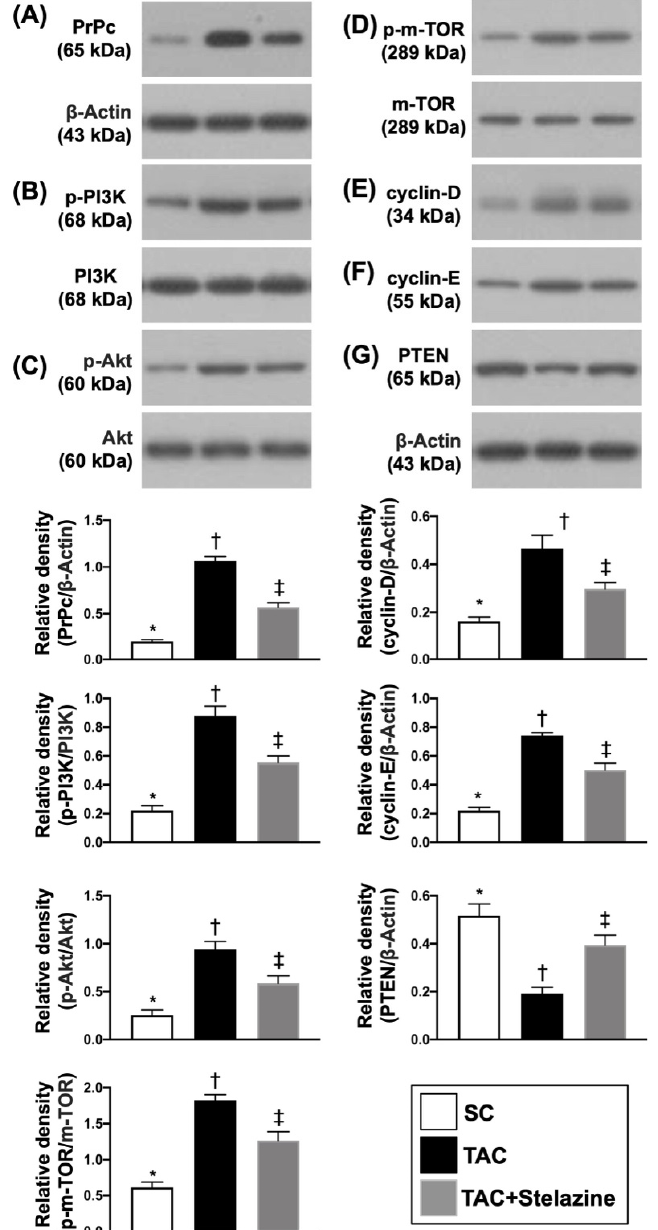
Figure 5. Protein expressions of PrP C , cell stress, and proliferation signalings by day 28 after TAC procedure. ( A ) Protein expression of PrP C , * vs. other groups with different symbols (†, ‡), p < 0.0001. ( B ) Protein expression of p-PI3K, * vs. other groups with different symbols (†, ‡), p < 0.0001. ( C ) Protein expression of p-AKT, * vs. other groups with different symbols (†, ‡), p < 0.0001. ( D ) Protein expression of p-m-TOR, * vs. other groups with different symbols (†, ‡), p < 0.0001. ( E ) Protein expression of cyclin D, * vs. other groups with different symbols (†, ‡), p < 0.0001. ( F ) Protein expression of cyclin E, * vs. other groups with different symbols (†, ‡), p < 0.0001. ( G ) Protein expression of P-TEN, * vs. other groups with different symbols (†, ‡), p < 0.0001. All statistical analyses were performed by one-way ANOVA, followed by Bonferroni multiple comparison post-hoc test (n = 6 for each group). Symbols (*, †, ‡) indicate significance (at 0.05 level). SC = sham-operated control TAC = transverse aortic constriction; PI3K = phosphoinositide 3-kinase; m-TOR = mammalian target of rapamycin (m-TOR); RAC(Rho family)-alpha serine/threonine-protein kinase; P-TEN = phosphatase and tensin